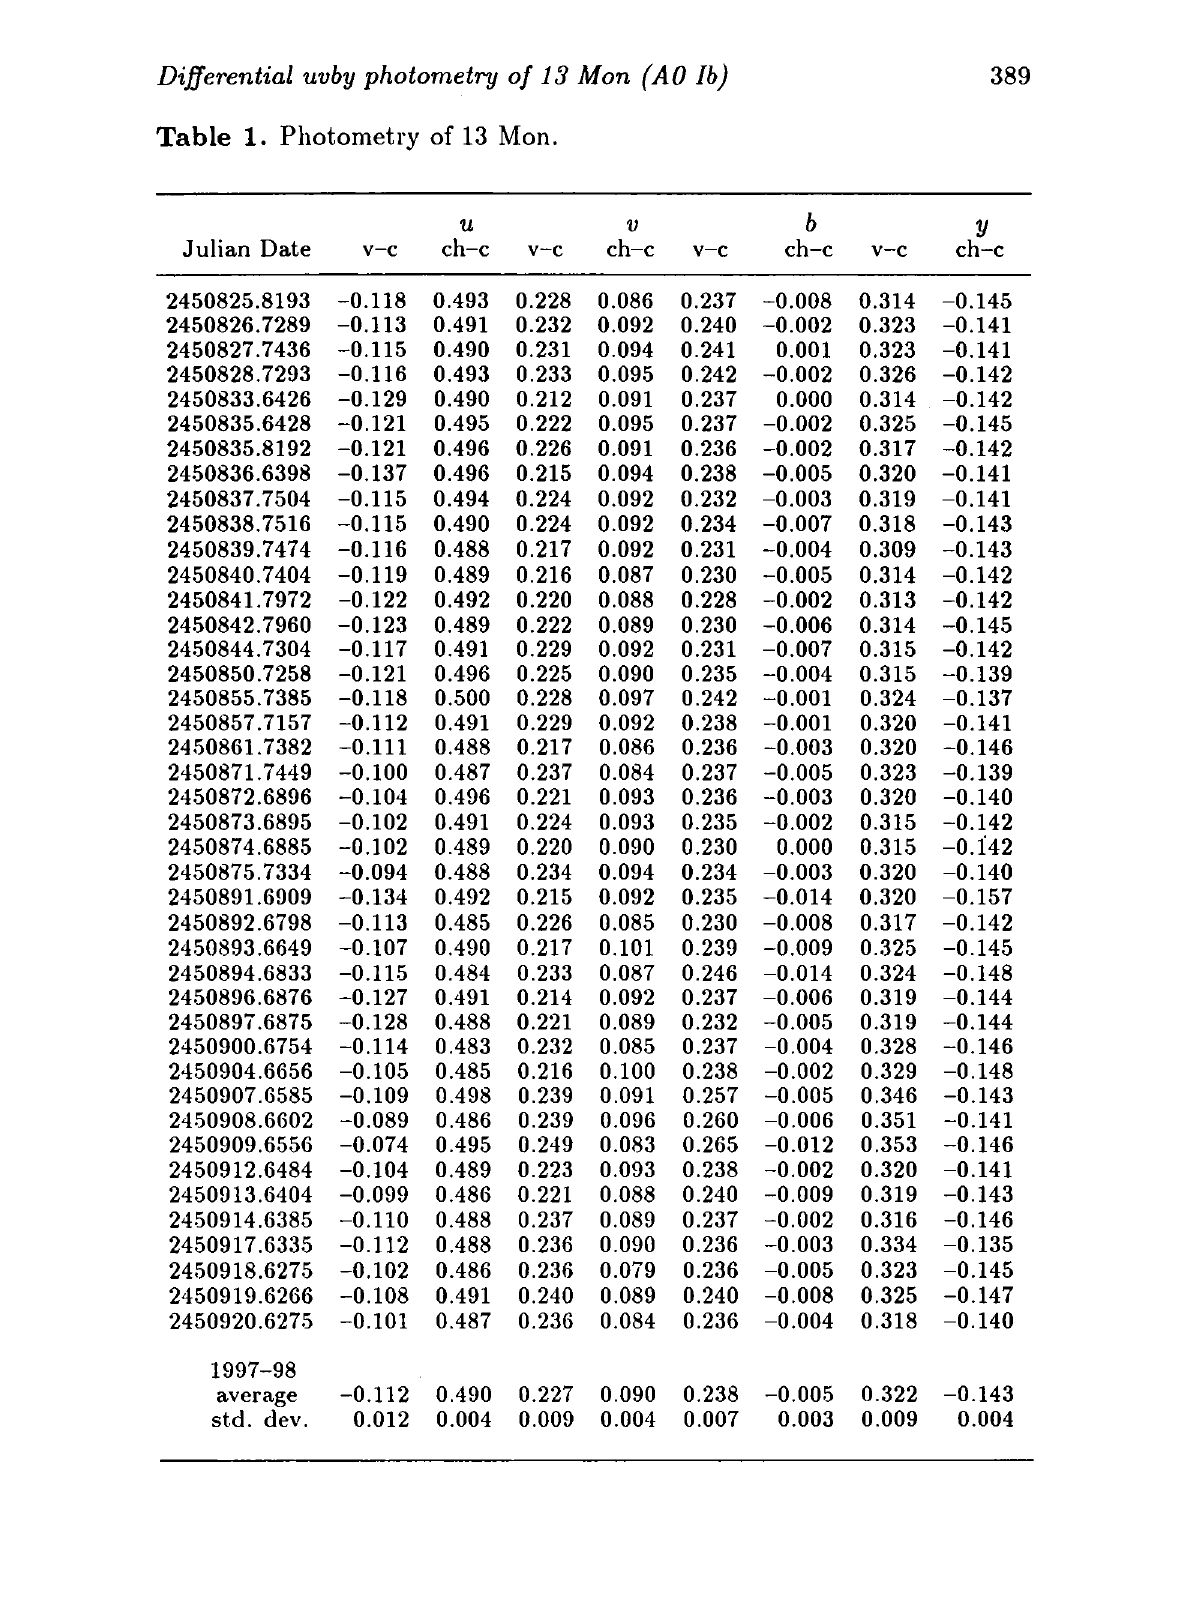
Table 1. Photometry of 13